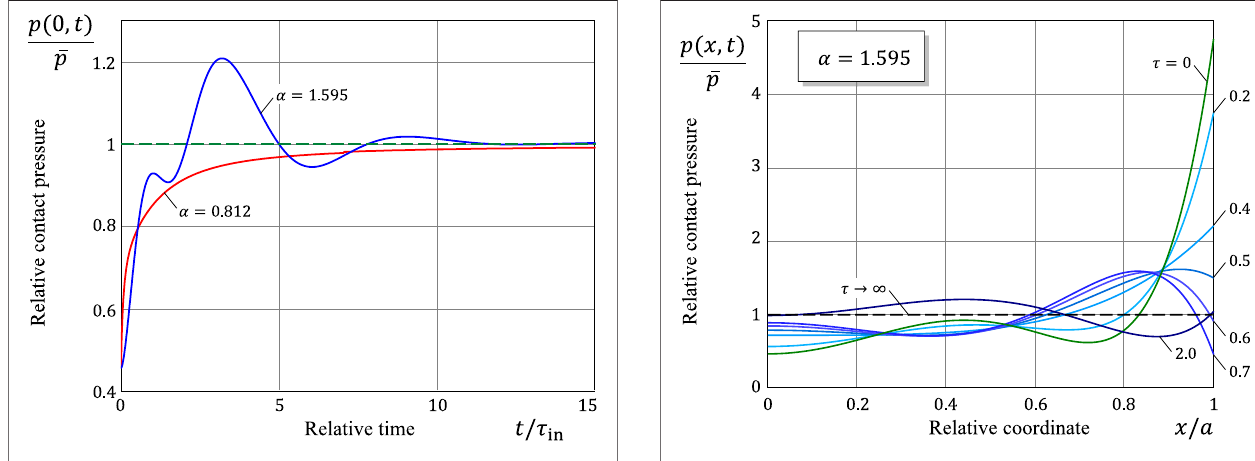
FIGURE 7 | Space-variation of the contact pressure for different values of the relative time variable τ = t / τ in in the super-Archard wear case.